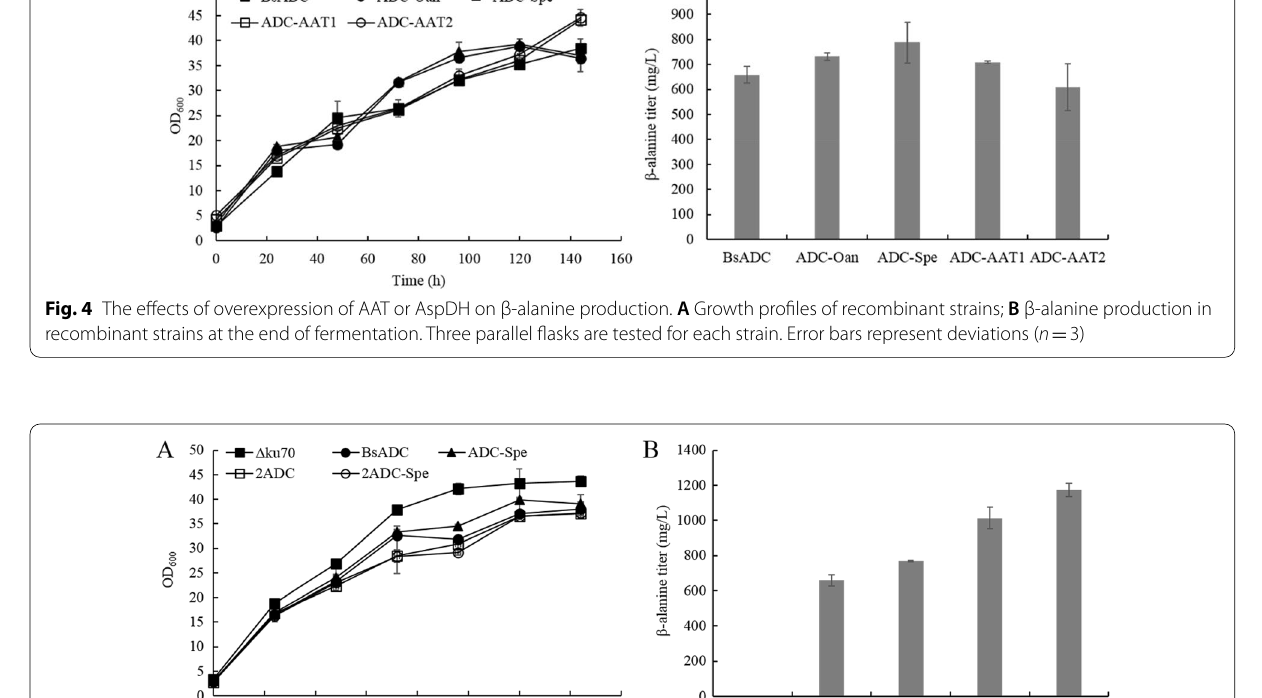
Fig. 5 The effects of increasing ADC copy number on β-alanine production. A Growth profiles of recombinant strains; B β-alanine production in recombinant strains at the end of fermentation. Three parallel flasks are tested for each strain. Error bars represent deviations ( n